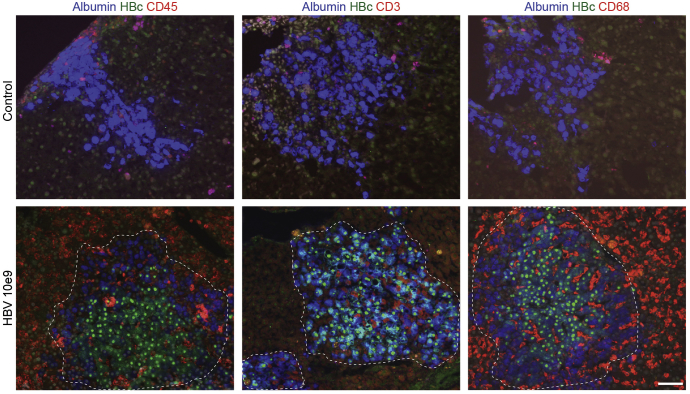
Human immune cells are recruited to the liver in chronically infected HIS-HUHEP mice. Immunofluorescence analysis of liver sections from control (top panels) and HBV-infected (bottom panels) mice co-stained for hAlbumin (blue) and HBc (green), with either hCD45 (red), or hCD3 (red), or hCD68 (red). DAPI-stained nuclei are shown in grey. Scale bar represents 100 μm.